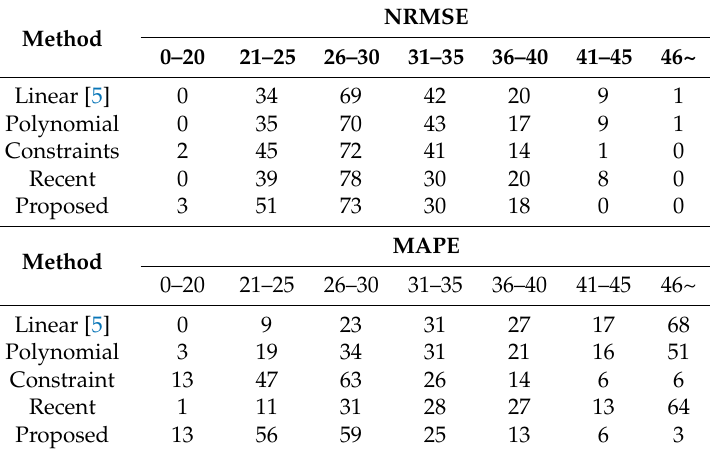
Table 5. The distribution of estimation errors of stations when we apply the proposed methods each and all. The best result is when we apply all